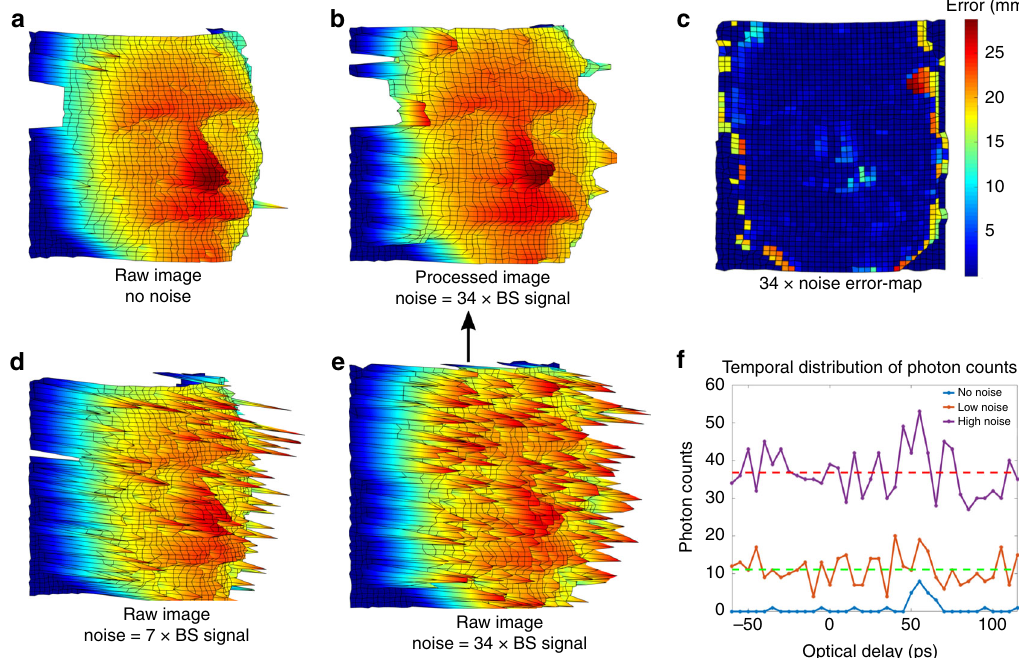
Fig. 4 Noise-tolerant imaging. a Noise free raw 3D image of target, acquired with mean photon number of 15 detections per pixel. b Reconstructed 3D image acquired with 34 times noise photons after a median fi lter has been applied. c Error map of reconstructed 3D image ( b ), with noise free 3D image ( a ) as ground truth. d , e The raw 3D images acquired with the presence of 7 and 34 times noise. f Time-resolving photon counting at different noise levels, where the dashed lines mark the average number of 7 (green) and 34 (red) times noise photons counted at each ODL